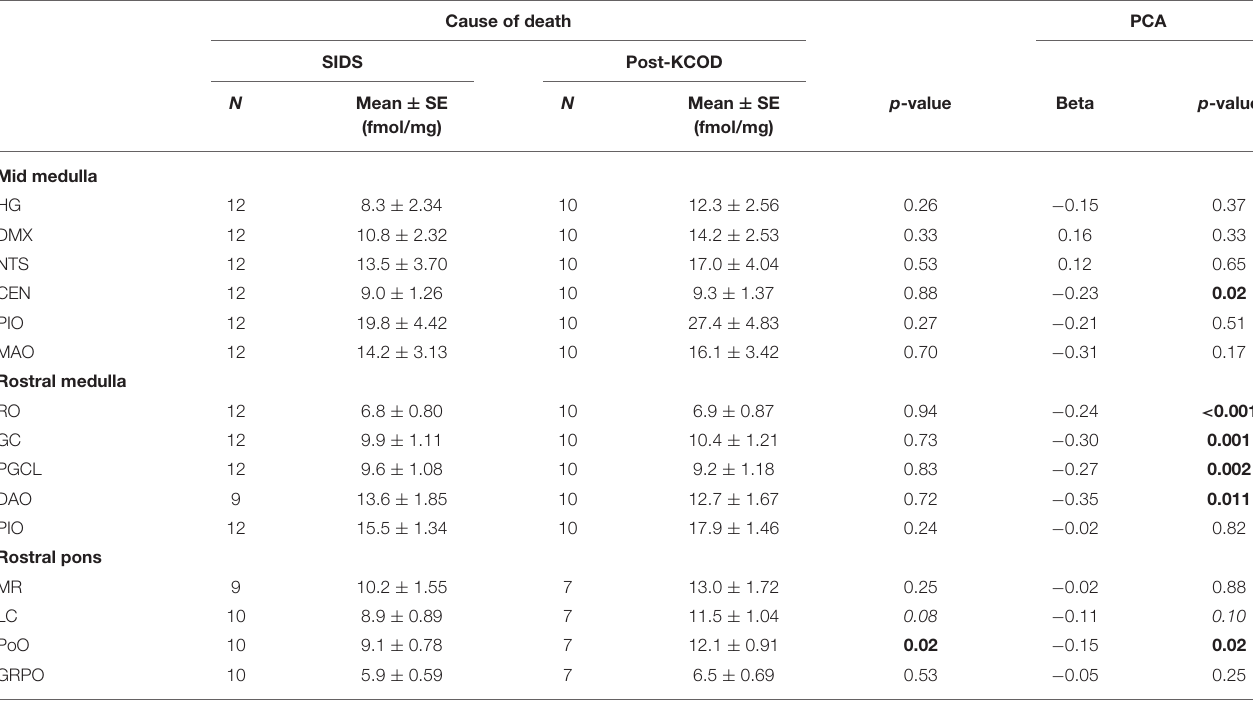
TABLE 5 | Effect of diagnosis controlling for PCA on 125 I-epibatidine binding in the brainstem. Cause of death PCA SIDS Post-KCOD